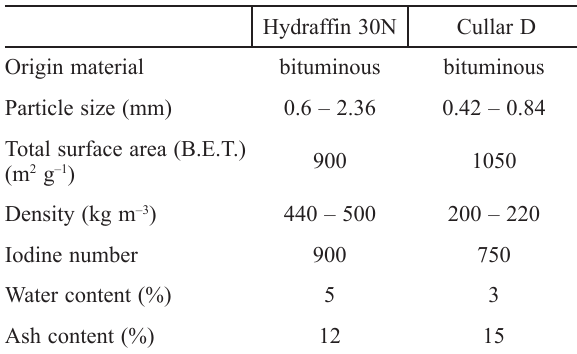
Table 1 – Characteristics of tested bituminous coal-based activated